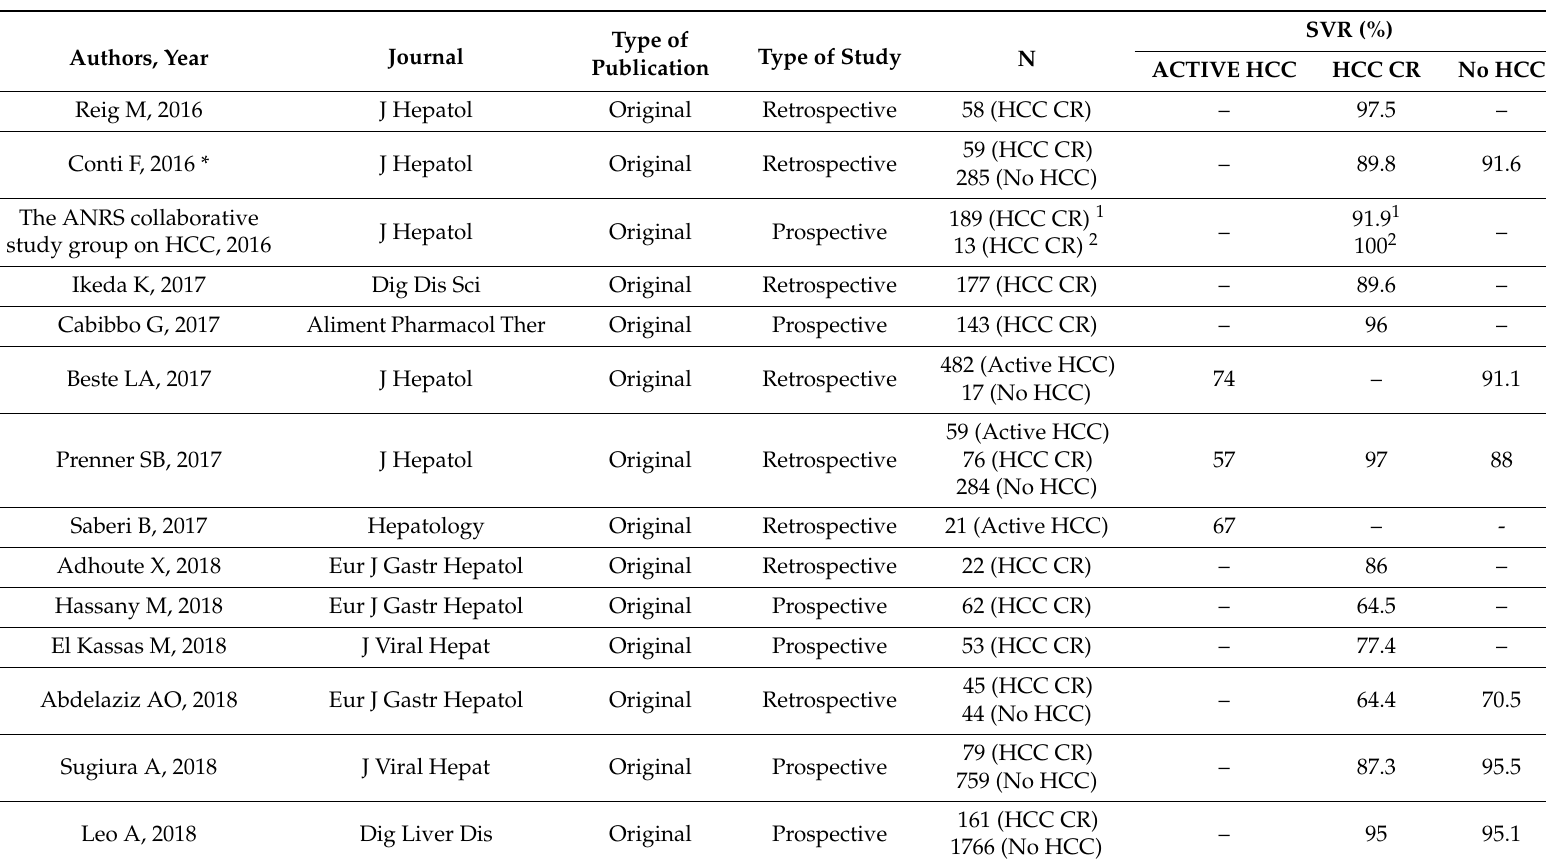
Table 1. Studies reporting analysis of hepatocellular carcinoma (HCC) recurrence after direct antiviral agents (DAA) treatment according to the rate of sustained viral response